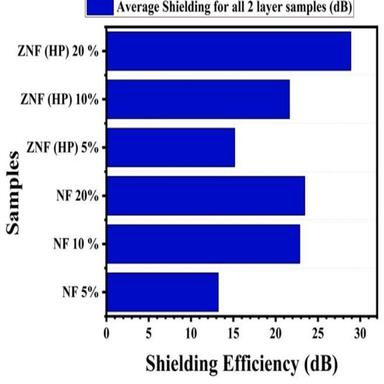
Average shielding efficiency for all 2-layer NF and ZNF(HP).